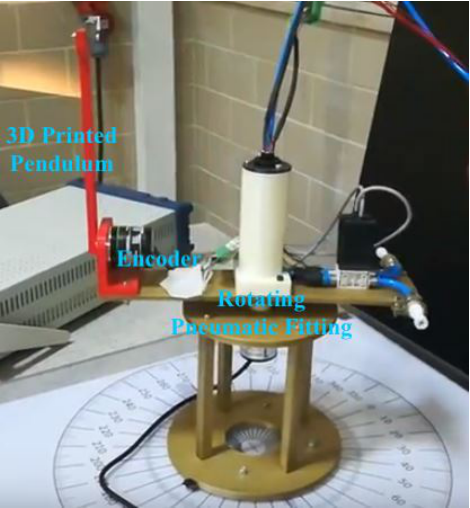
Figure 7. Rotary inverted pendulum test